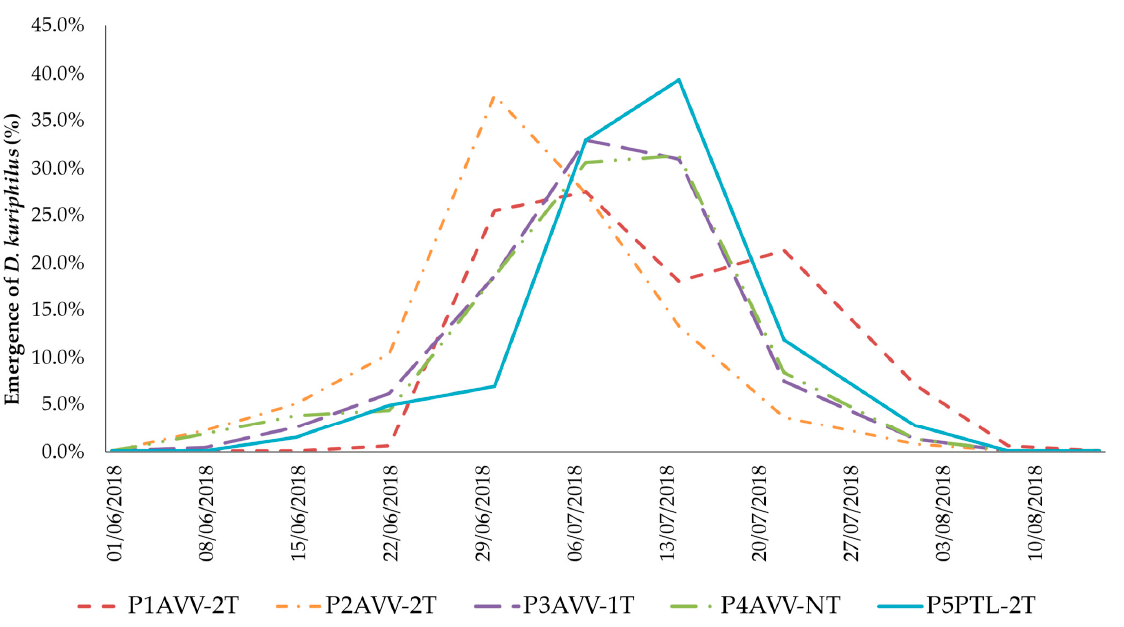
Figure 4. Weekly evolution of D. kuriphilus emergence in five chestnut orchards in Minho (P1–P5) located in Arcos de Valdevez (AVV) and Ponte de Lima (PTL), with one (1T), two (2T) or no treatment (NT) of T. sinensis in 2018.